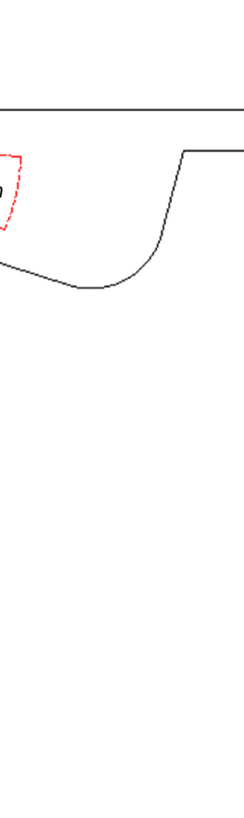
Figure 3. Schematic of the engine working cycle (TDC: Top dead center, BDC: Bottom dead center; IVC: Intake valve closes; EVO: Exhaust valve opens; SOI: Start of injection; EOI: End of injection)